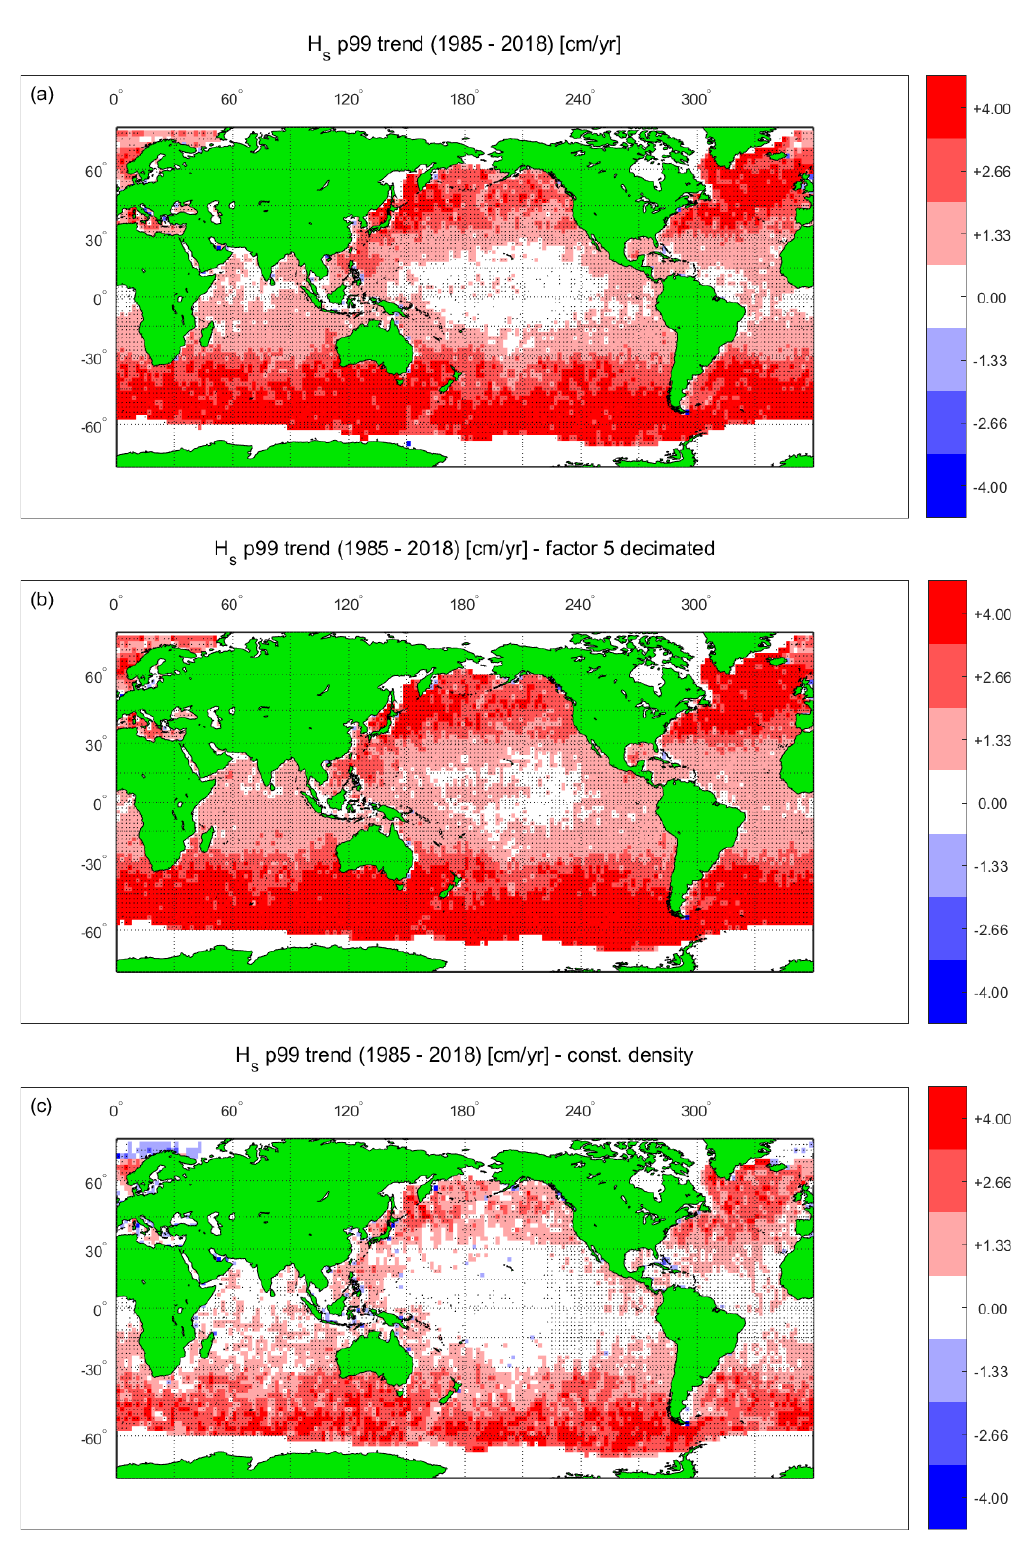
Figure 9. As for Figure 8 but trend for 99th percentile significant wave height. ( a ) All altimeter data used, ( b ) Data decimated by a factor of five, ( c ) More recent altimeter missions removed to yield approximately constant data density as a function of time. Values which are statistically significant at the 95th percent level are shown by small dots.